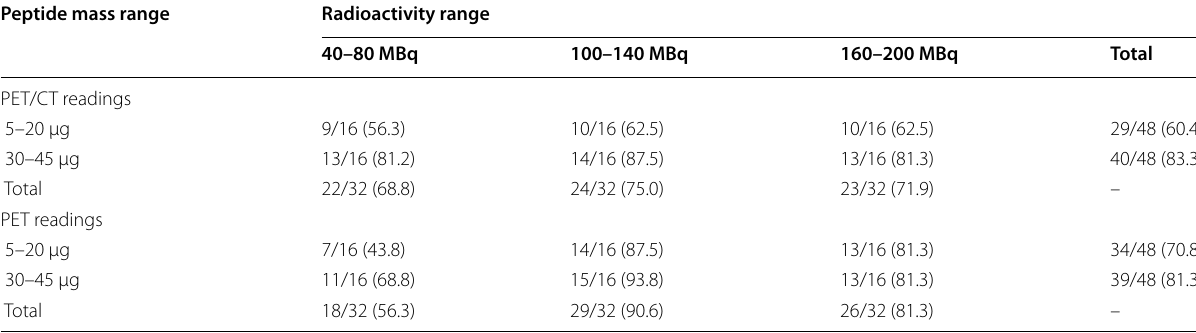
During the image quality readings, each image was assigned a “1” (for optimal image quality) or a “0” (for non-optimal image quality). For each pair of patient images of 68 Ga-satoreotide trizoxetan obtained on day 1 and day 16–22 of the study, one or both images could score “1”. The numerator of the image quality score is the sum of both readers’ scores, and the denominator is the total number of PET/CT and PET scans that were read and scored Data are presented as n / N (%) CT computed tomography, PET positron emission tomography